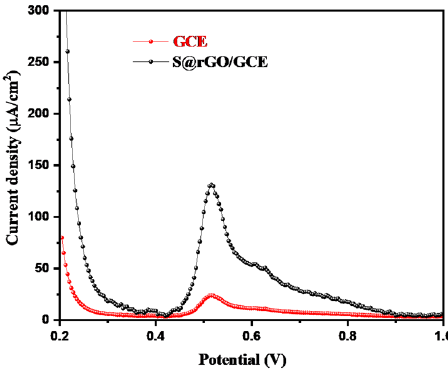
Figure 7. DPV pattern of GCE and S@rGO/GCE in presence of 125 µM acetaminophen in 0.1 M PBS (pH = 7.0; scan rate = 50 mV/s).